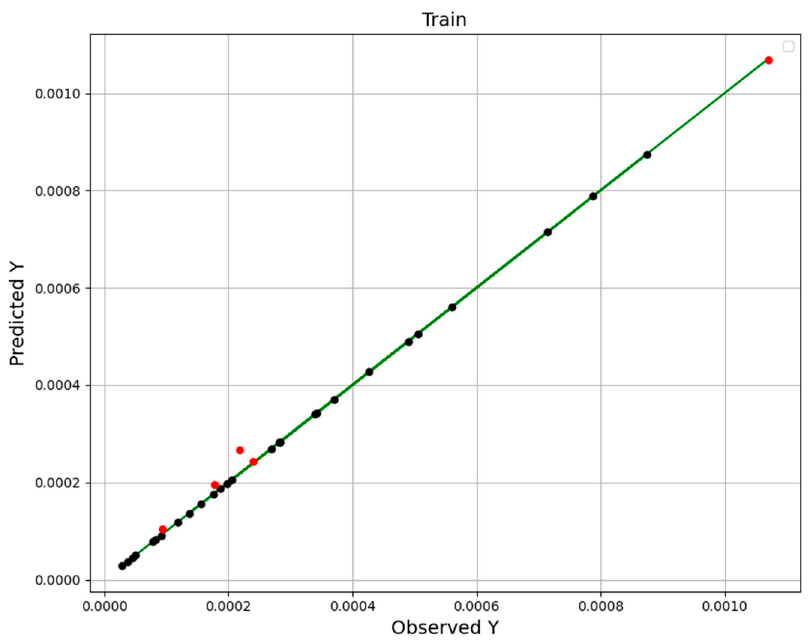
Figure 4. GBRT Model: test and train data predictions . Table 2. Outputs.